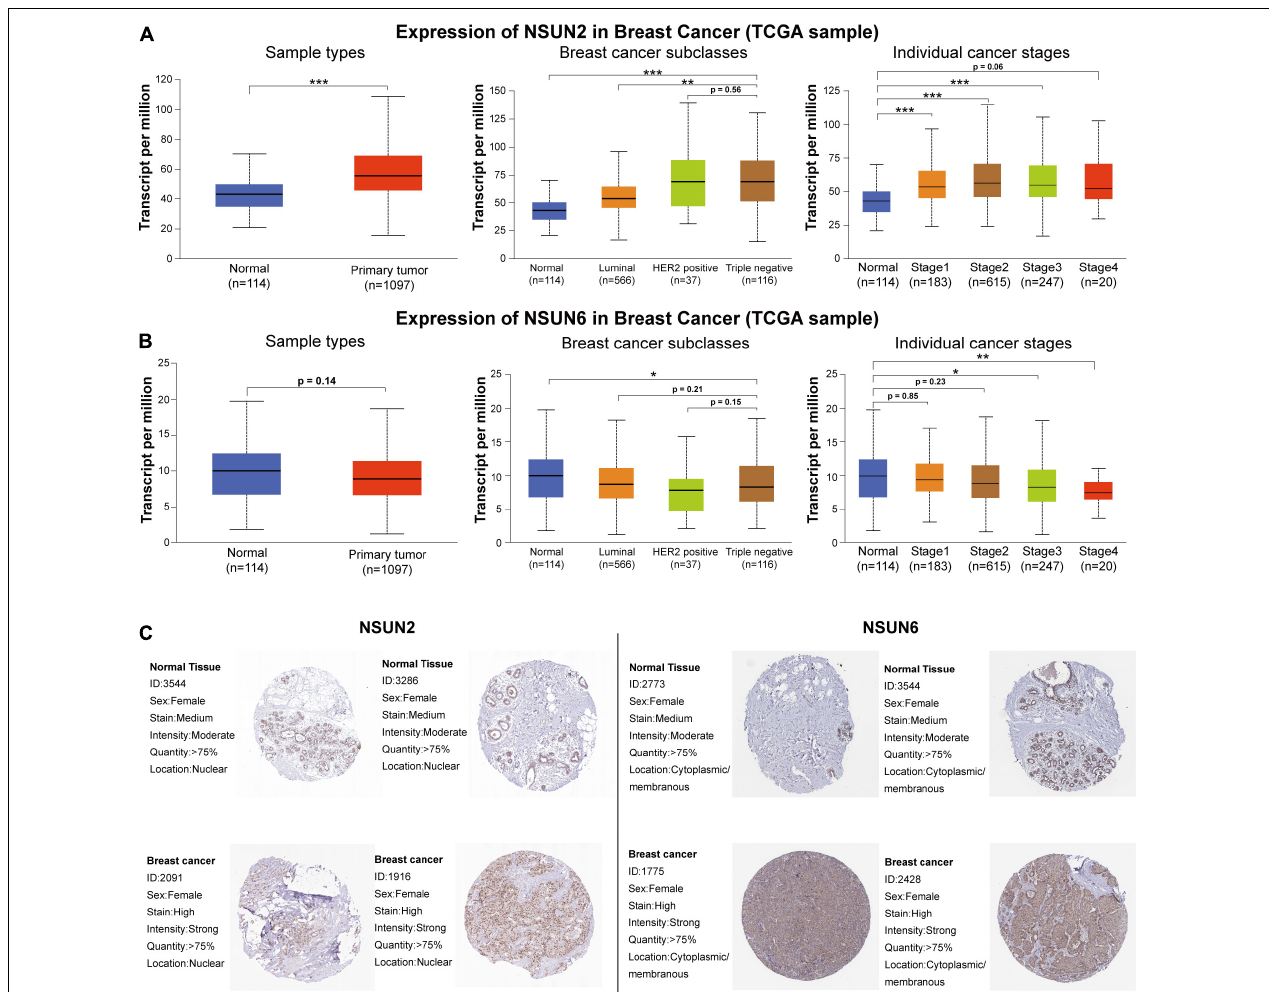
FIGURE 4 | Correlation between the differential expression of the two prognostic genes and clinicopathological patient characteristics and the difference in the expression of these genes at the protein level between normal tissues and breast cancer tissues. mRNA expression of NSUN2 and NSUN6 genes by molecular subtype and histological grade (A,B) . The difference in protein expression of NSUN2 and NSUN6 in normal breast tissue and primary breast cancer tissue in the Human Protein Atlas (C) . * p < 0.05, ** p < 0.01, and *** p < 0.001. NSUN, NOP2/Sun domain family